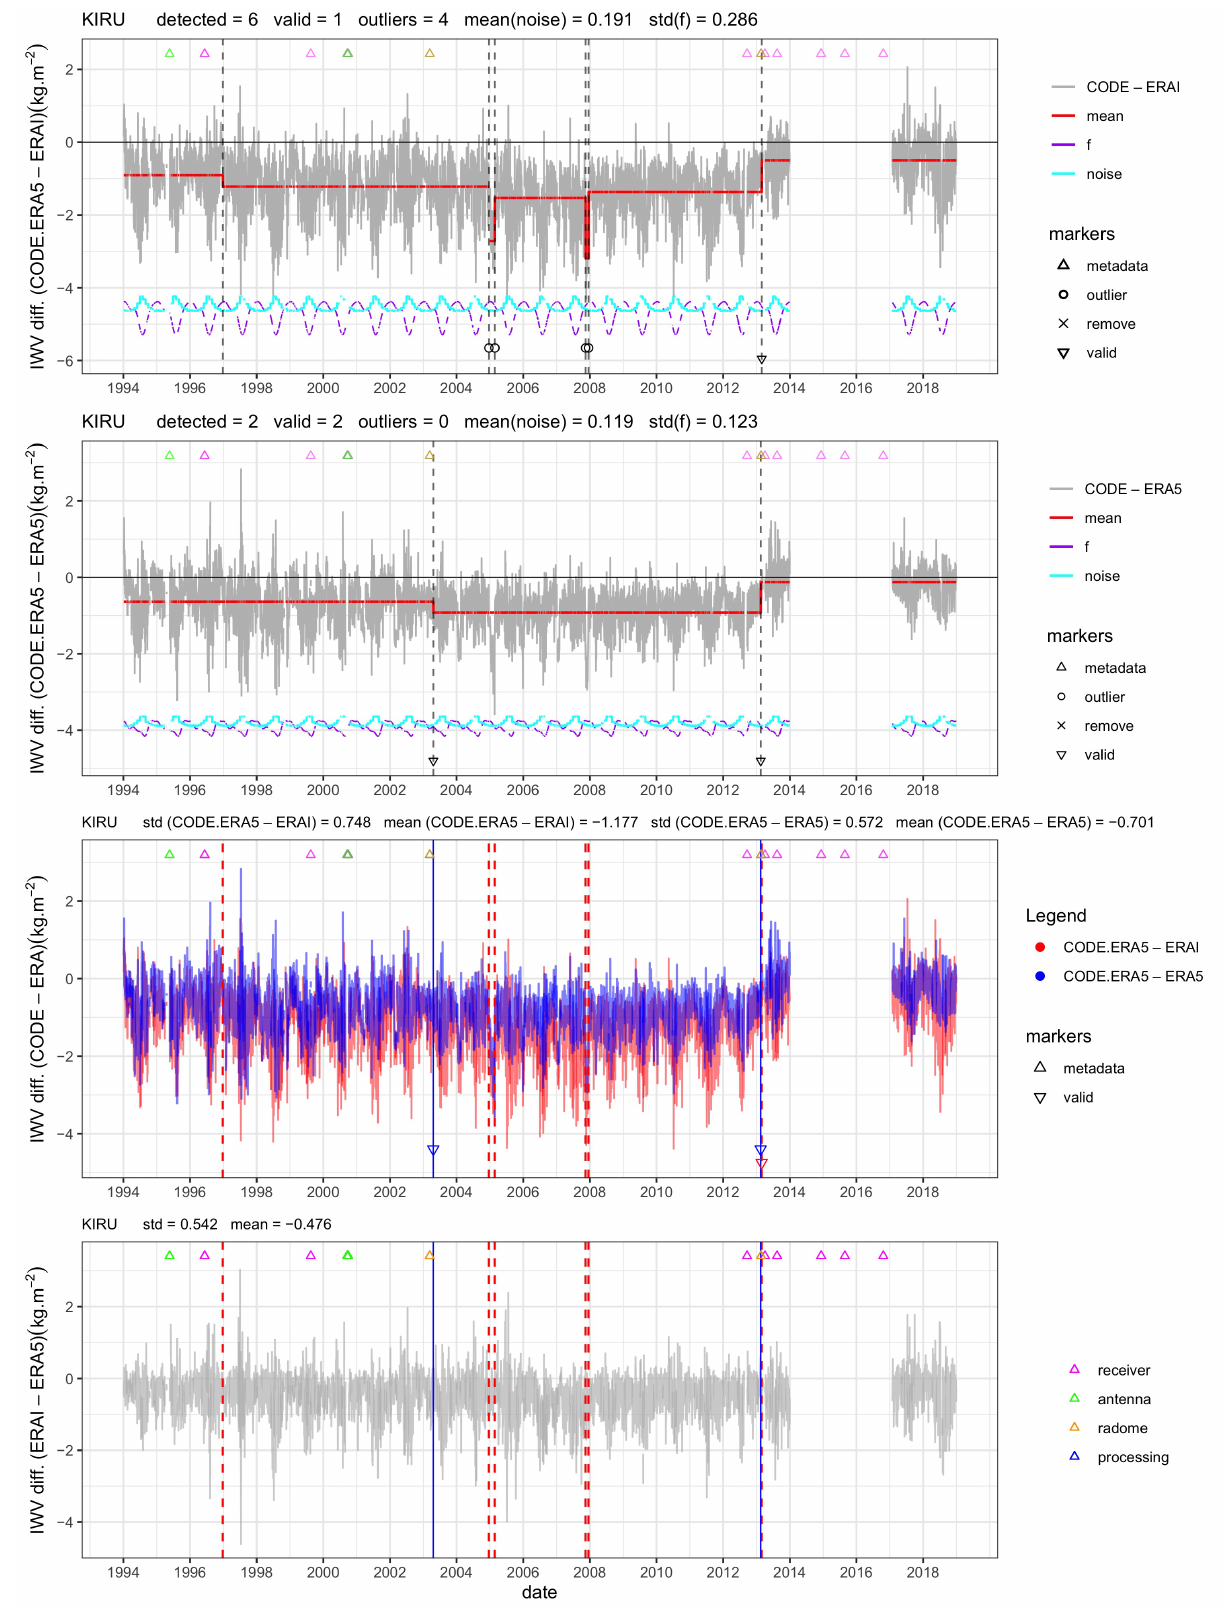
Figure 11. Similar to Figure 4, but for station KIRU (Kiruna,